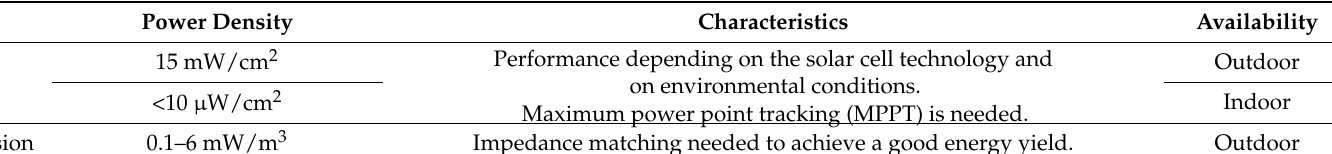
Table 1. Selection of energy sources for supplying wireless